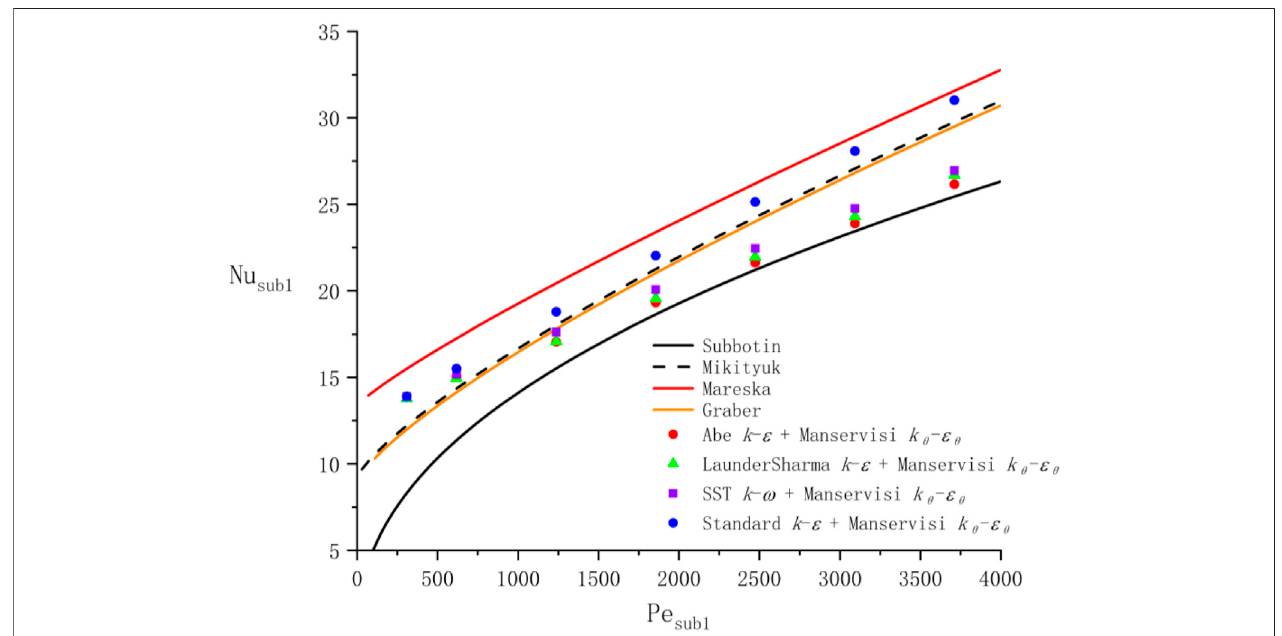
FIGURE 11 | Comparison of Nu sub 1 calculated by different turbulence models.